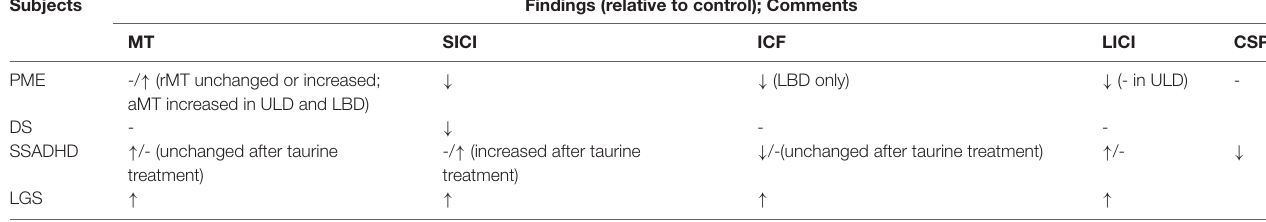
TABLE 3 | TMS-EMG metrics in rare